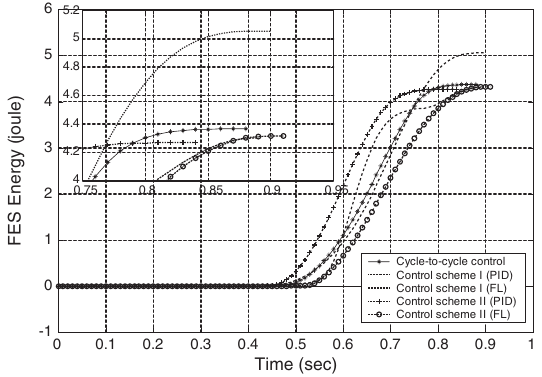
Fig. 19. FES induced mechanical energy input into plant for differ- ent control approaches. Magnified end values in the inset.